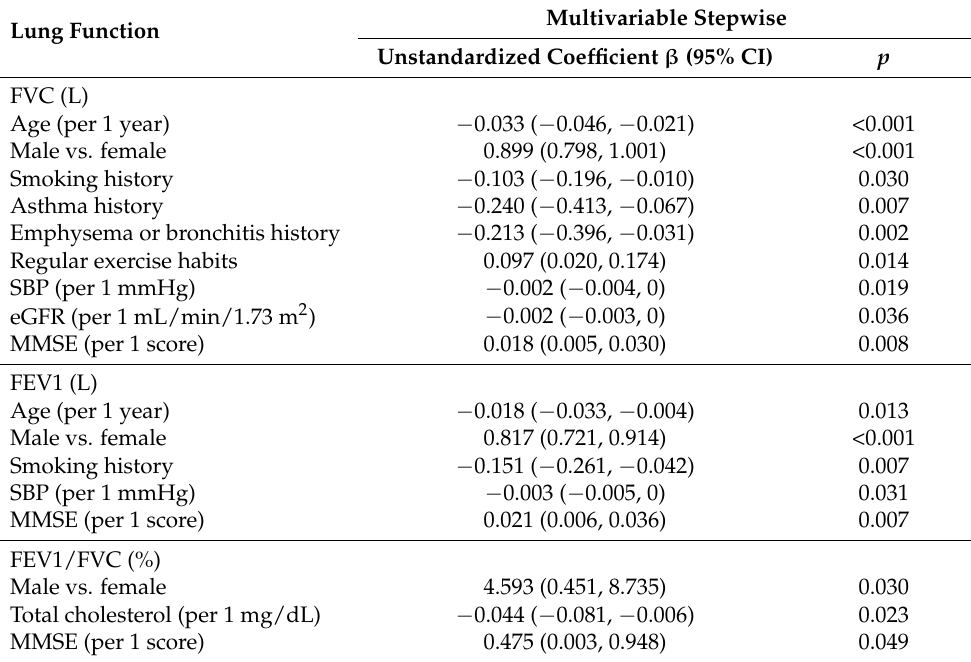
Table 2. Association of MMSE with FVC, FEV1 and FEV1/FVC using multivariable stepwise linear regression analysis in all participants ( n =